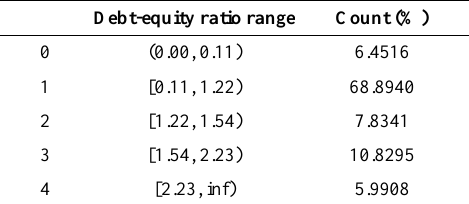
Table 4. Example of optimal bins of “debt-equity ratio” descriptors